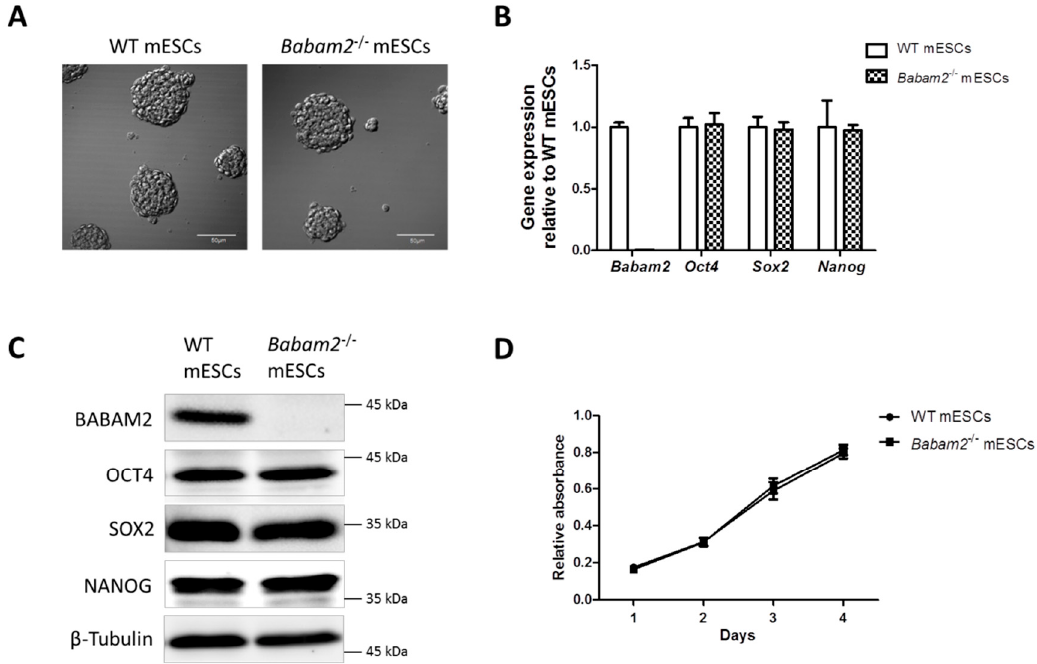
Figure 1. Characterization of wild-type WT and Babam2 − / − mouse embryonic stem cells (mESCs). ( A ) Morphology of WT and Babam2 − / − mESCs maintained on gelatin-coated cell culture plates under feeder-free condition. Scale bar = 50 µ m. ( B ) Relative Babam2 mRNA expression and three pluripotency-associated markers in WT and Babam2 − / − mESCs, normalized to Gapdh . ( C ) Western blot analysis for expression of BABAM2 and pluripotency-associated markers in WT and Babam2 − / − mESCs. ( D ) Proliferation curves for WT and Babam2 − / − mESCs were measured as relative to cck-8 absorbance. The data show the mean of three independent experiments.